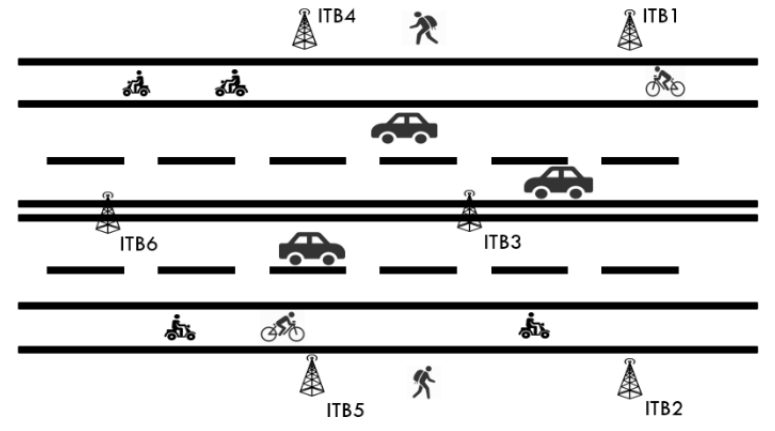
Figure 3. Research scenario.